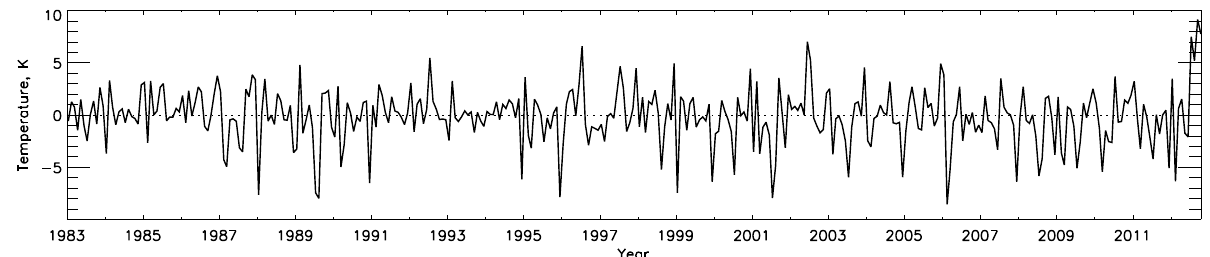
Figure 7. The UBDC index from the CCM SOCOL model in specified-dynamics mode using ERA-Interim from 1983 to